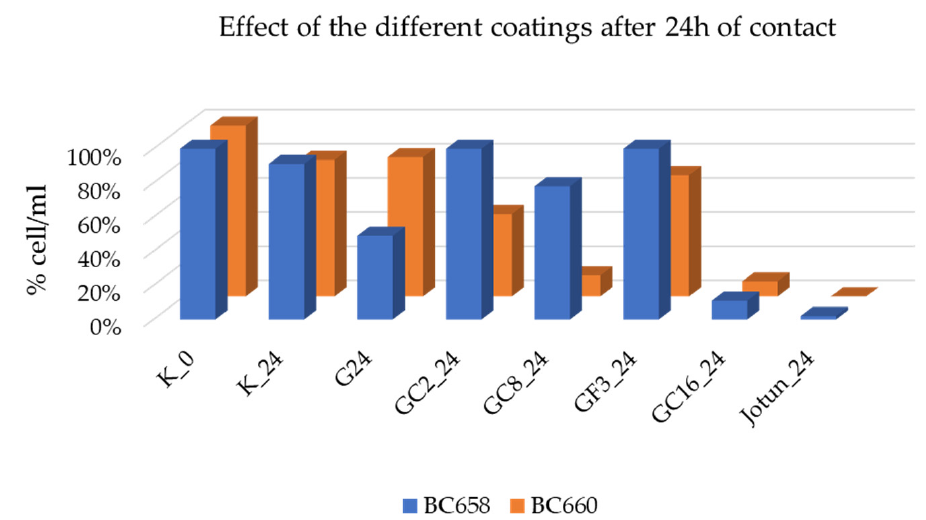
Figure 12. Bacterial strains behavior after 24 h of contact with the untreated (K) and treated with functionalized coatings glass slides. Bacteria are: a Gram—strain Stenotrophomonas maltophilia BC 658 and Gram + strain Rossellomorea aquimaris BC 660. Strains growth was expressed in percentage of viable and culturable cell/mL.